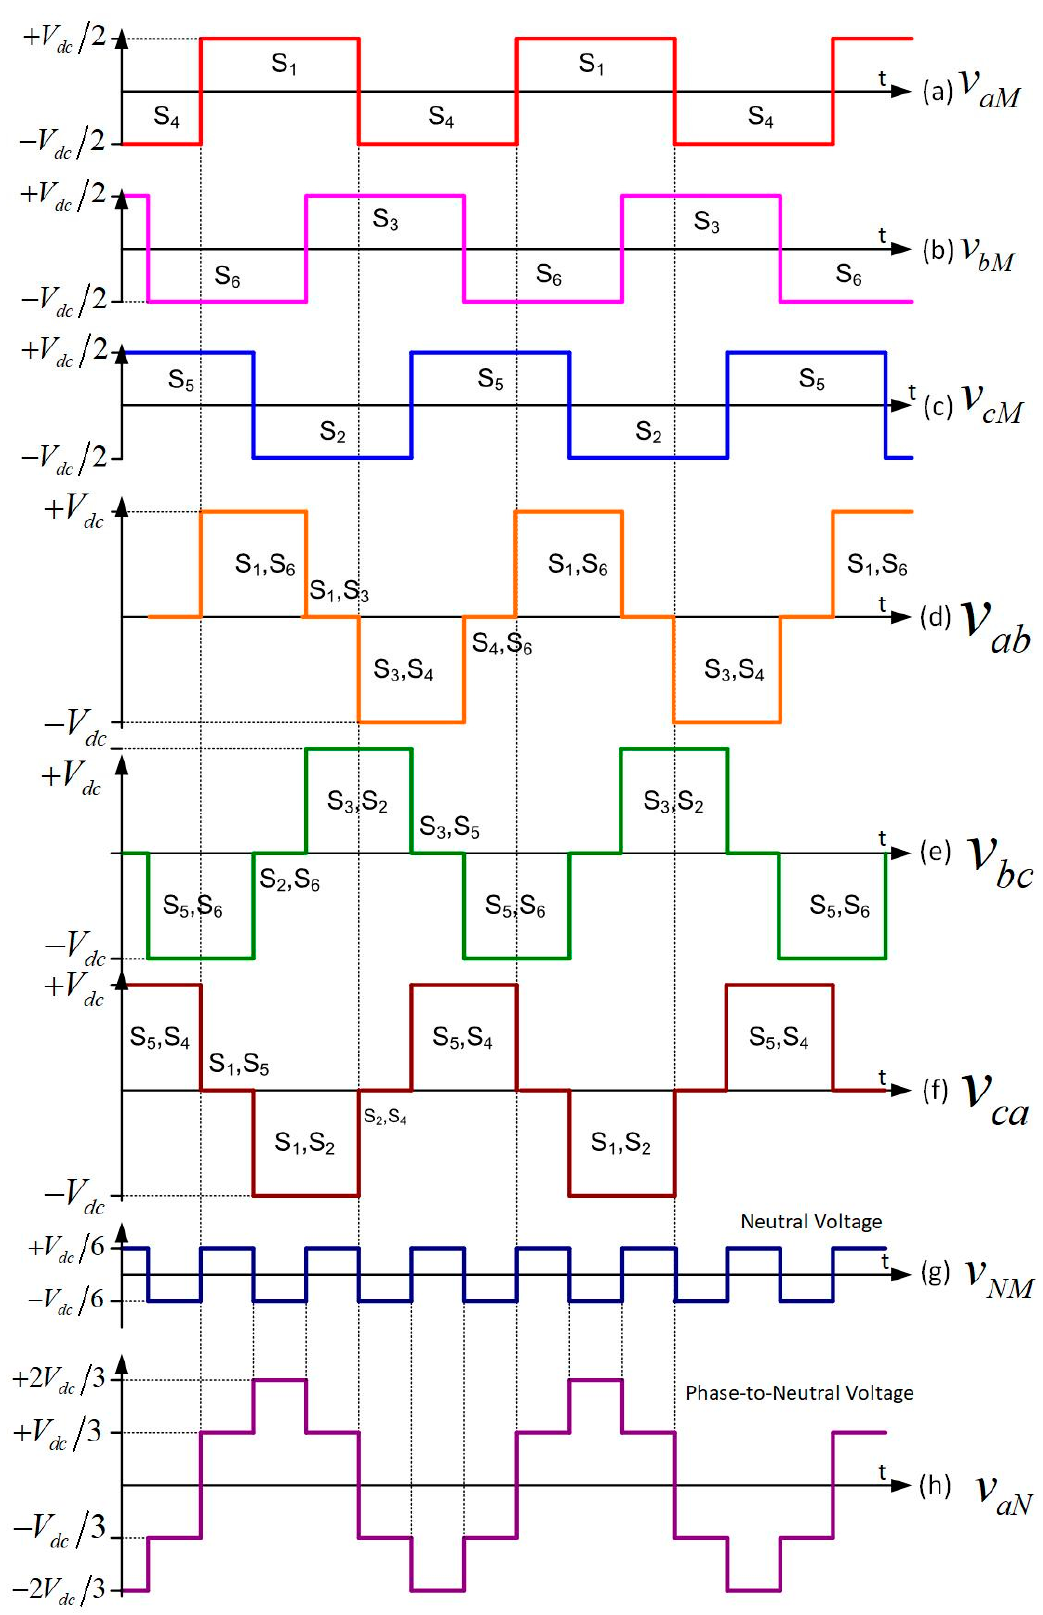
Figure 15. Voltage waveforms for the basic 6-pulse VSC using fundamental frequency switching. Waveforms ( a – c ): Phase-to-DC-midpoint voltages; waveforms ( d – f ): Phase-to-phase voltages; waveform ( g ) Neutral voltage with respect to DC-midpoint; waveform ( h ) Phase-to-neutral voltage of phase a.